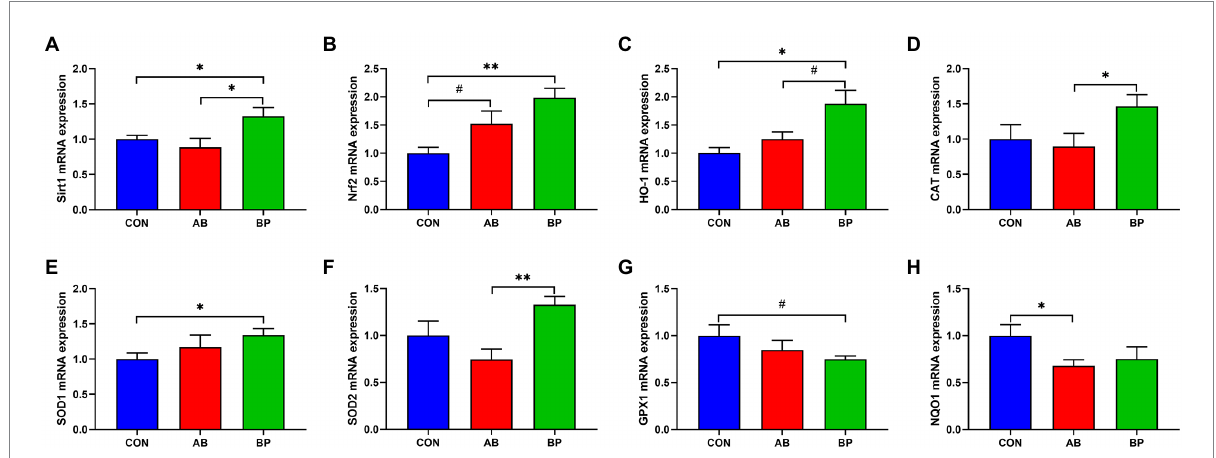
FIGURE 9 Effects of dietary supplemented with Bopu powder on expressions of antioxidant genes in intestine of broiler chickens. (A) Sirtuin1 ( Sirt1 ); (B) Nuclear factor erythroid 2-related factor 2 ( Nrf2 ); (C) Heme-oxygenase 1 ( HO-1 ); (D) Catalase ( CAT ); (E) Superoxide dismutase 1 ( SOD1 ); (F) Superoxide dismutase 2 ( SOD2 ); (G) glutathione peroxidase-1 ( GPX1 ); and (H) NAD(P)H quinone oxidoreductase 1 ( NQO1 ). CON group, broiler chickens fed a basal diet; AB group, broiler chickens fed a basal diet supplemented with 50 mg/kg aureomycin; BP group, broiler chickens fed a basal diet supplemented with 40 mg/kg Bopu powder containing protopine and allocryptopine. Values are mean ± standard error ( n = 6). # 0.05 ≤ p < 0.10, * p < 0.05, ** p < 0.01.